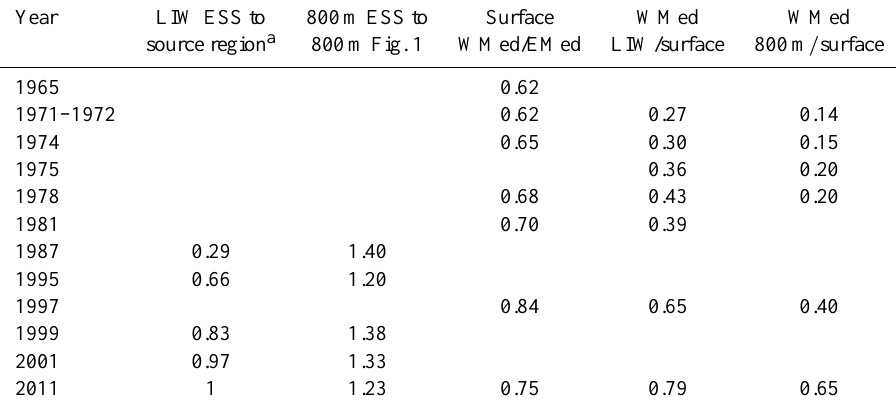
Table 2. Ratios of tritium concentrations between various water masses. Data sources see Table 1, EMed surface water values see Fig. 1. Free space if no available data. The LIW at the entrance into Sicily Strait (ESS) is represented by data near to 250m and in the WMed in 450–500m. The WMed/EMed surface water ratios for 1971–1972, 1981, and 1997 use EMed values of Fig. 1 interpolated in time between